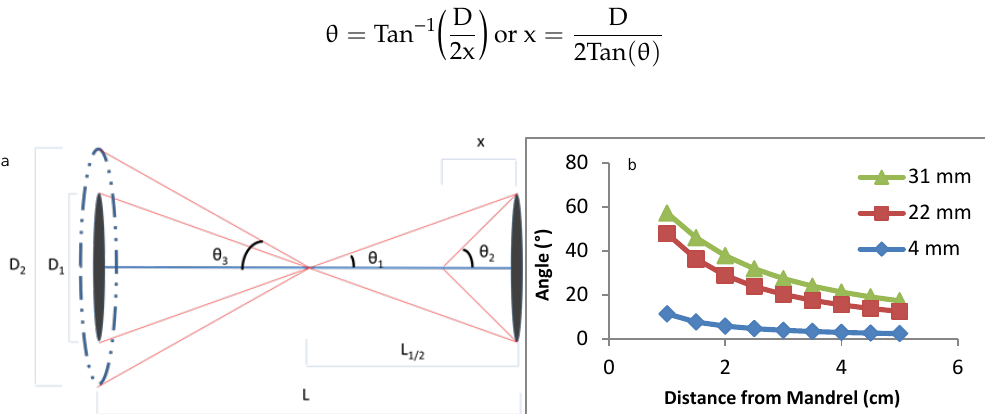
Figure 5. ( a ) Diagram and Equation (3) of a theoretical polymer fiber wrapping around the glass microfiber, where D is the diameter of the mandrel, θ is the angle the fiber wraps around the glass fiber, L is the length between mandrels, and x is the distance from the mandrel. ( b ) Theoretical fiber angles with mandrel diameters of 4, 22, and 31 mm at varying distances.